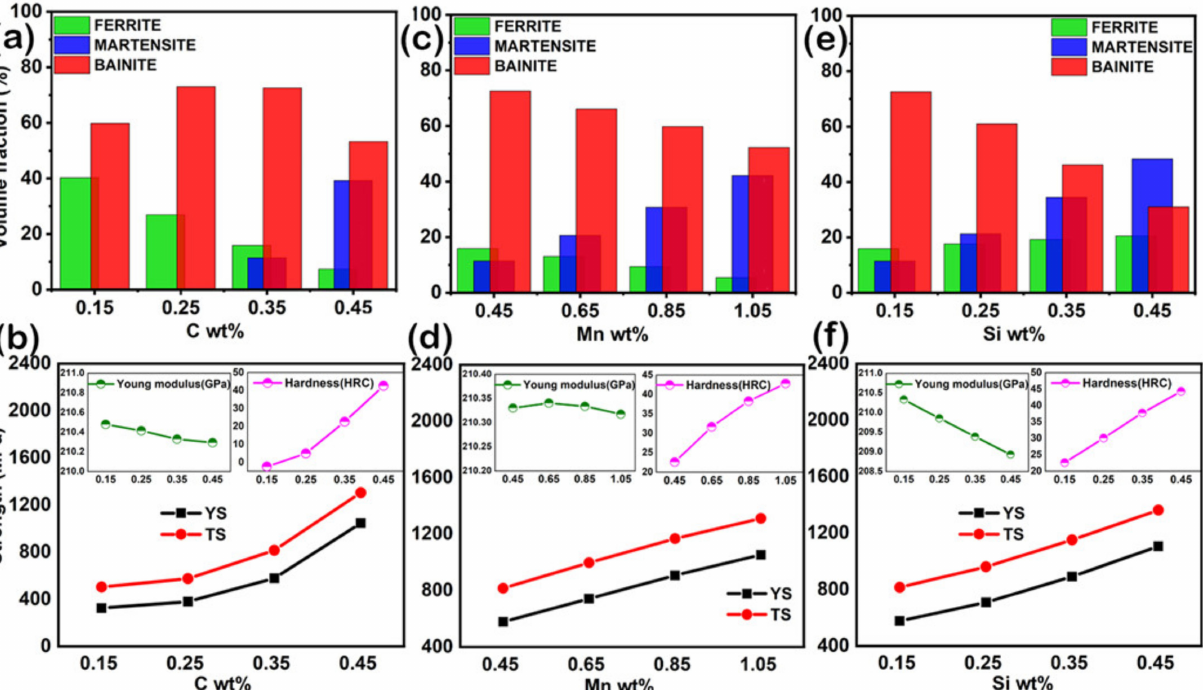
Figure 5. Effect of C content ( a ) Volume fraction of phases; ( b ) Tensile strength, yield strength, Young’s modulus and hardness of MS 1 alloys at room temperature, effect of Mn content; ( c ) Volume fraction of phases w.r.t Mn; ( d ) Tensile strength, Yield strength, Young modulus, and hardness of MS 2 Alloys at room temperature, effect of Si content; ( e ) Volume fraction of phases w.r.t Si; ( f ) Tensile strength, yield strength, Young modulus, and hardness of MS 3 Alloys at room